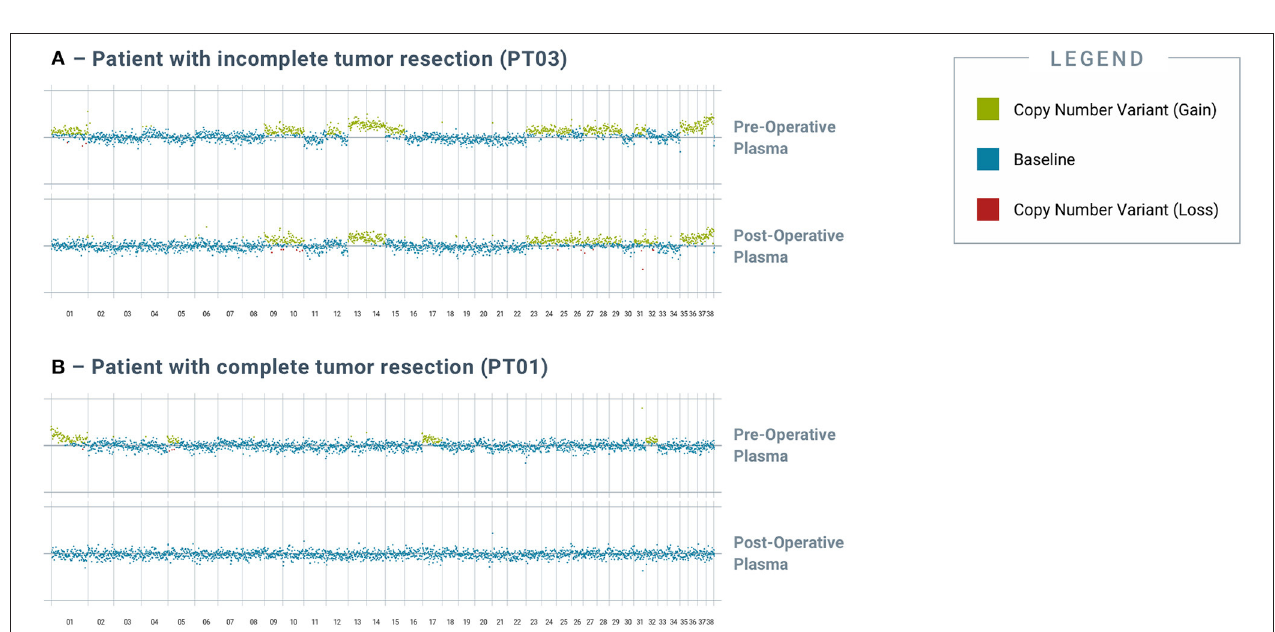
FIGURE 2 | Blood-derived plasma cfDNA captures heterogeneous alterations from five spatially separated sites across multiple organs. Results from PT03, a 14-year-old female spayed mixed breed dog diagnosed with multiple cancers are shown. Five tissue samples were collected from five distinct tumor sites: pancreas (pancreatic carcinoma), omentum (metastatic pancreatic carcinoma), spleen (hemangiosarcoma), caudate liver (metastatic hemangiosarcoma), and left lateral liver (hepatocellular carcinoma). Each tumor sample revealed a unique combination of genomic alterations (SNVs and/or CNVs), some of which were shared across multiple sites. The majority of SNV and CNV alterations were collectively captured in pre-operative plasma cfDNA.